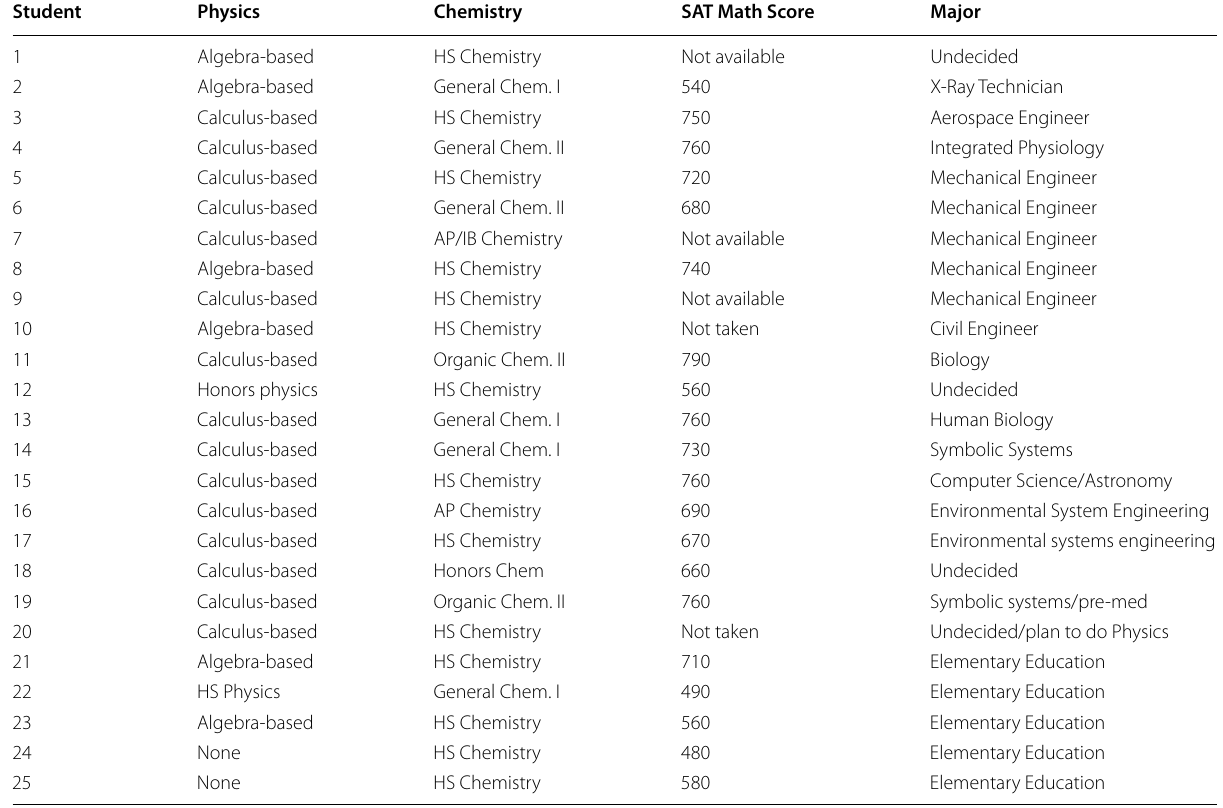
Table 2 Participants’ level of